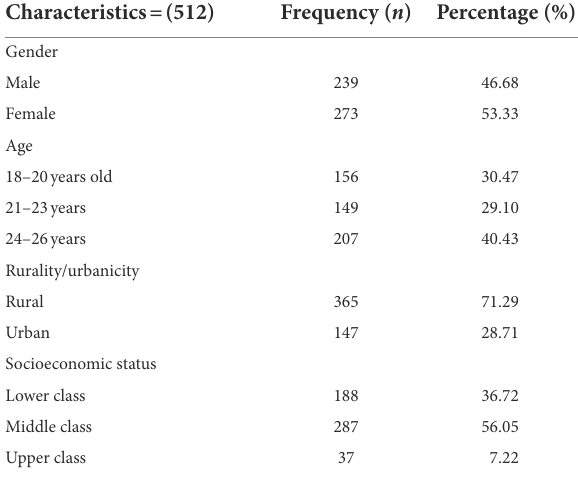
TABLE 1 Characteristics of